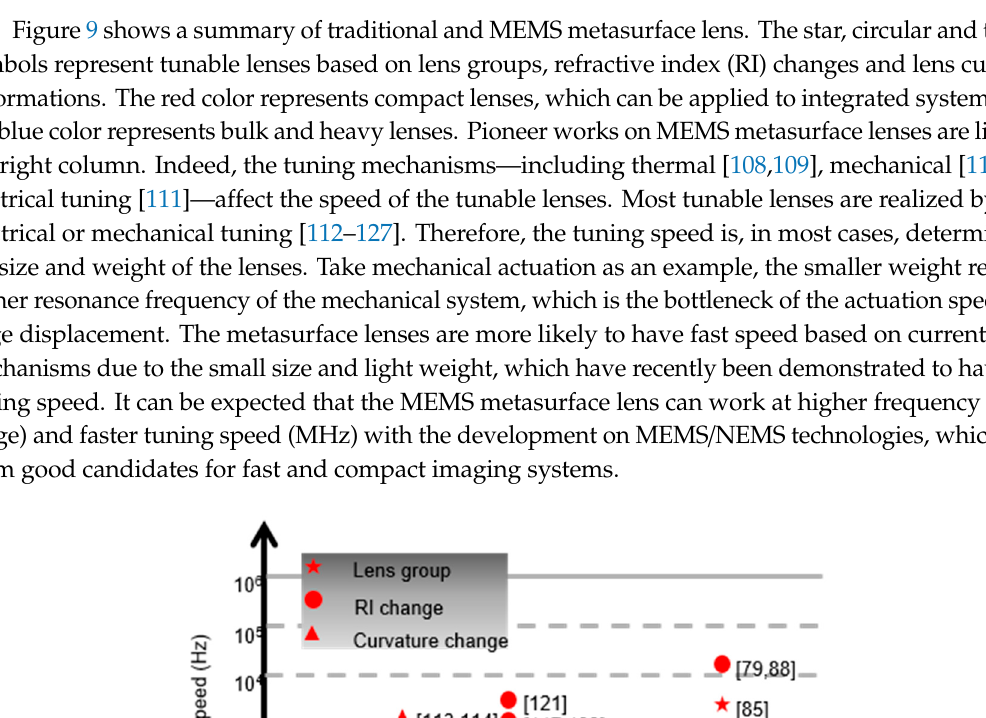
Figure 9. Summary of tunable lens by the tuning speeds and mechanisms. The red symbols represent tunable lenses, which can be applied to integrated systems. The blue symbols represent bulk and heavy lenses.